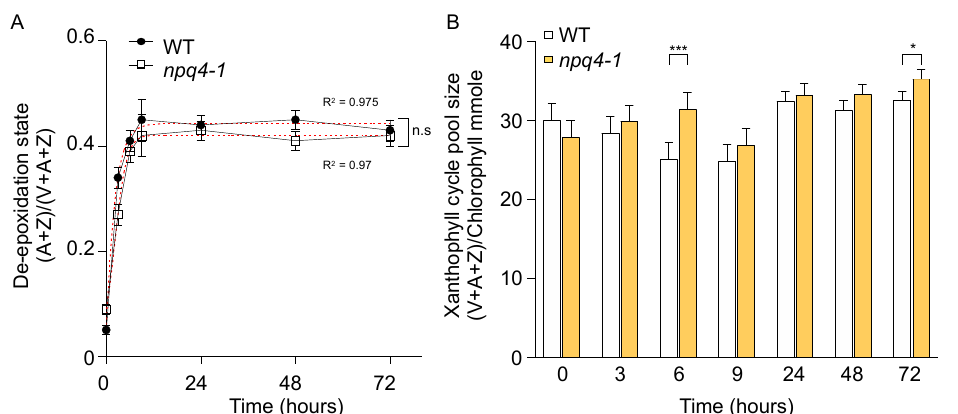
Figure 3. Changes in xanthophyll cycle pigment de-epoxidation state and pigment pool size in wild-type and npq4-1 mutants during high light illumination. ( A ) Xanthophyll cycle pigment de-epoxidation state is calculated as (A + Z)/(V + A + Z), where V is violaxanthin, A is antheraxanthin, and Z is zeaxanthin. Data are the means ± SE ( n = 3). Regression line plotted as red dashed line estimated via nonlinear least square regression. R 2 denotes the regression coefficient. Significance differences of fitted curves are indicated by asterisks (* p < 0.05; *** p < 0.001) compared to the WT as determined by unpaired Student’s t test; ( B ) Total xanthophyll cycle pigments in WT and npq4-1 mutants during HL treatments. Pool size was calculated by total chlorophyll a + b. Pigment was extracted by 80% acetone and analyzed by HPLC using absorbance at 460 nm. Significance differences are indicated by asterisks (* p < 0.05; *** p < 0.001) compared to the WT as determined by one-way ANOVA with Fisher’s LSD test.